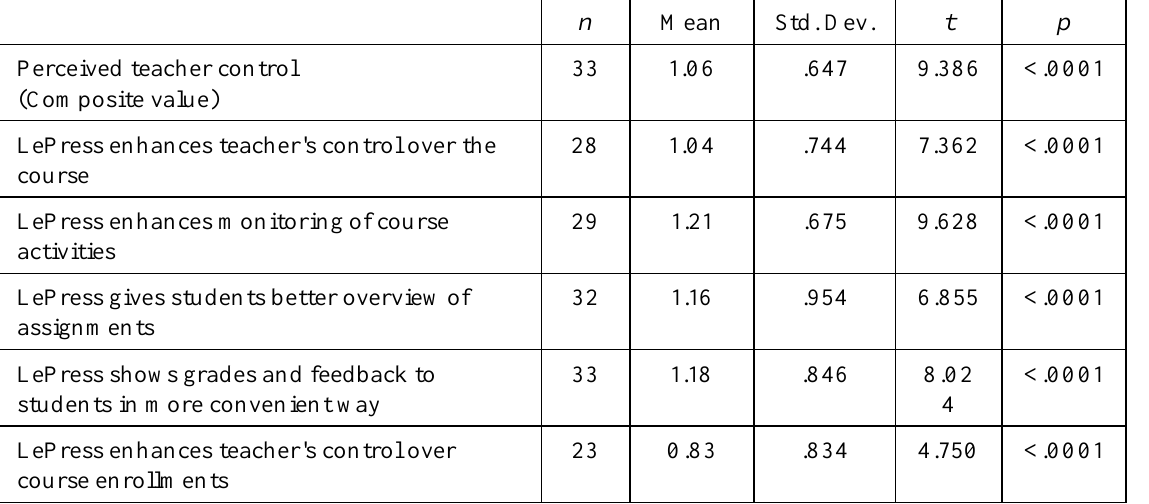
Perceived Teacher Control